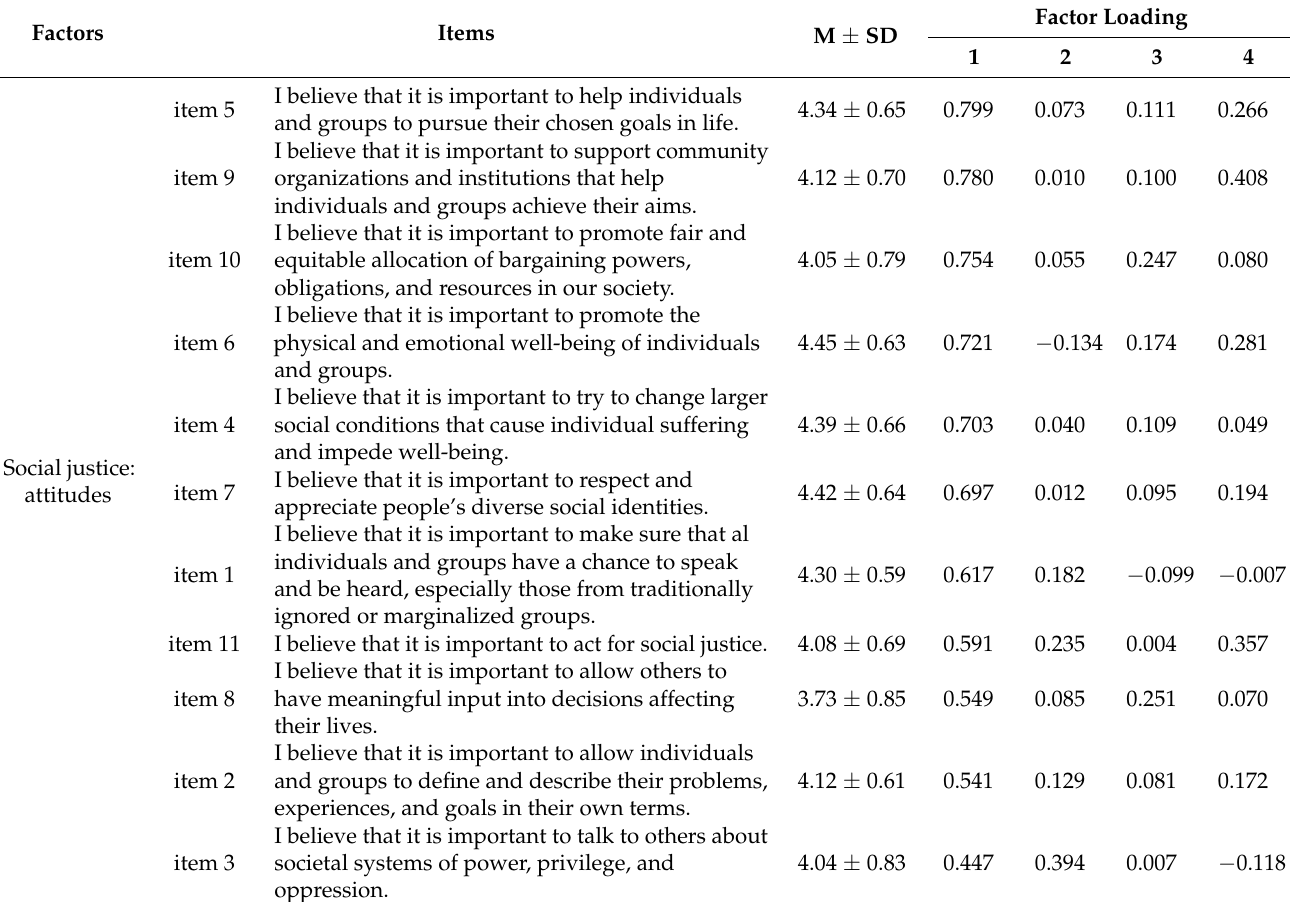
Table 2. Factor Analysis of Social Justice Scale ( N =